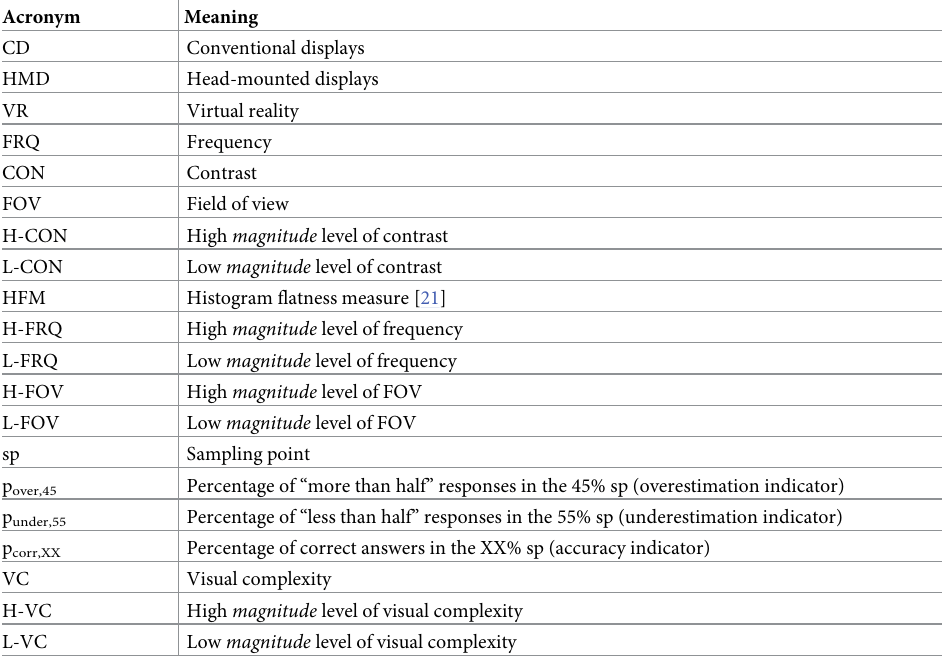
Table 1. List of acronyms used through this work.